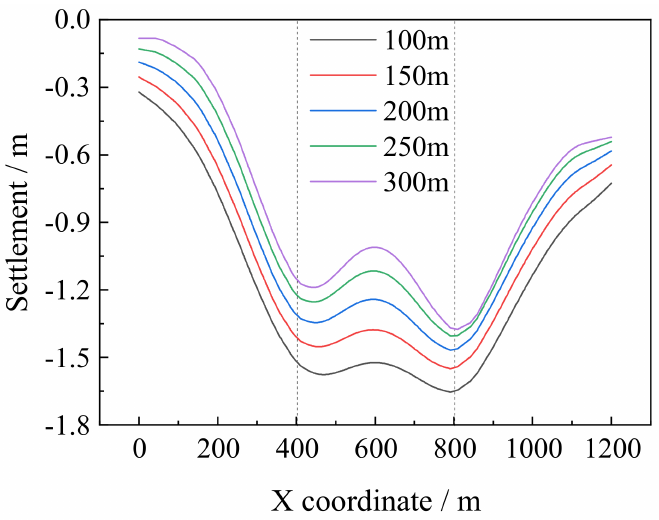
Figure 9. Settlement curves corresponding to different burial depths of the